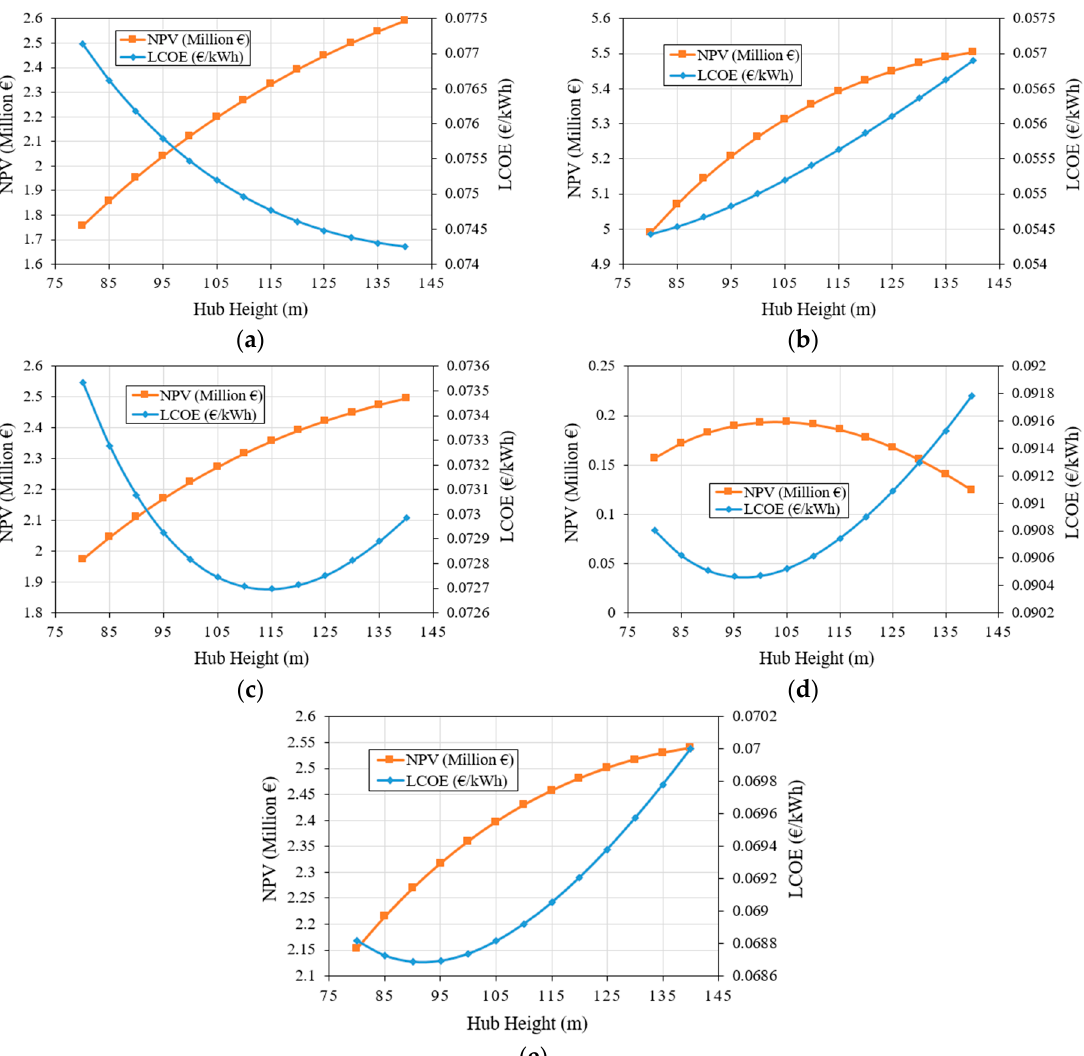
Figure 14. Effect of hub height on wind turbines economics at discount rate of 5% for Seo-San ( a ) WinDS 91.3/3000; ( b ) HJWT 87/2000; ( c ) 25s 90/2500; ( d ) STX 72/2000; ( e ) U 88/2000.